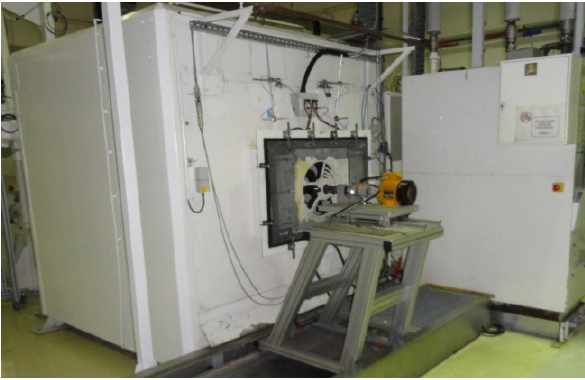
Figure 3. Test facility for the fan system or module performance measurement.